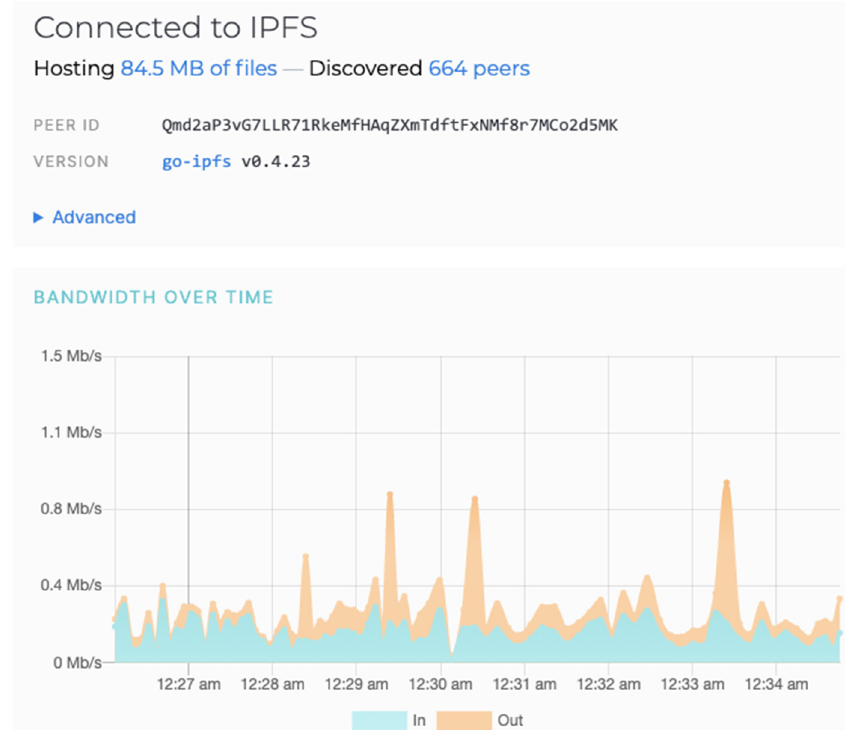
Figure 5. CDM concept and operation scheme.